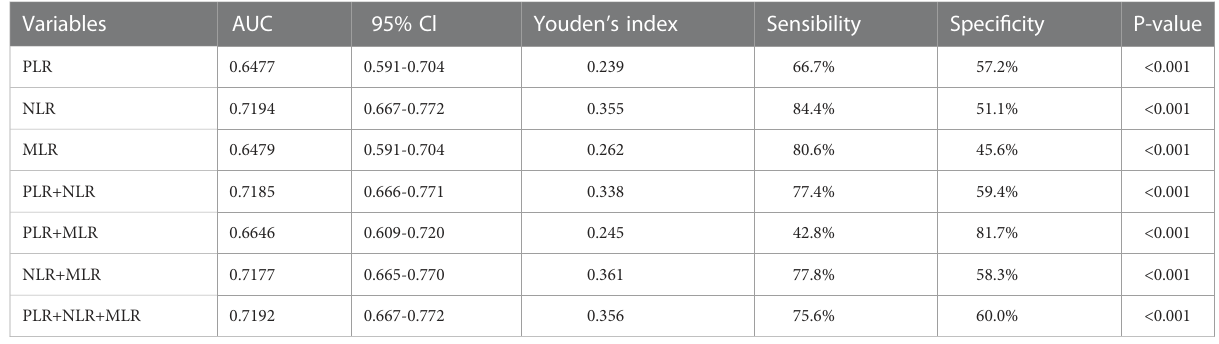
TABLE 5 ROC analysis of MLR, NLR, PLR, and combined diagnosis for arterial stiffness.